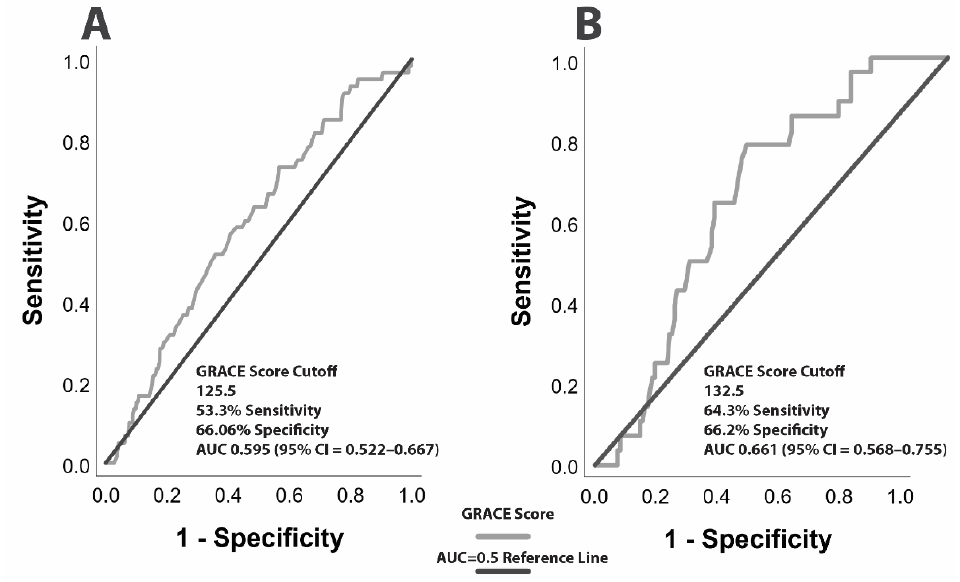
Figure 2. ROC curve on the predictive significance of the GRACE score for high-complexity CAD (SYNTAX score ≥ 33): ( A ) in ACS patients (AUC = 0.595, 95% CI = 0.522–0.667) and ( B ) in NSTEMI patients (AUC = 0.661, 95% CI = 0.568–0.755).